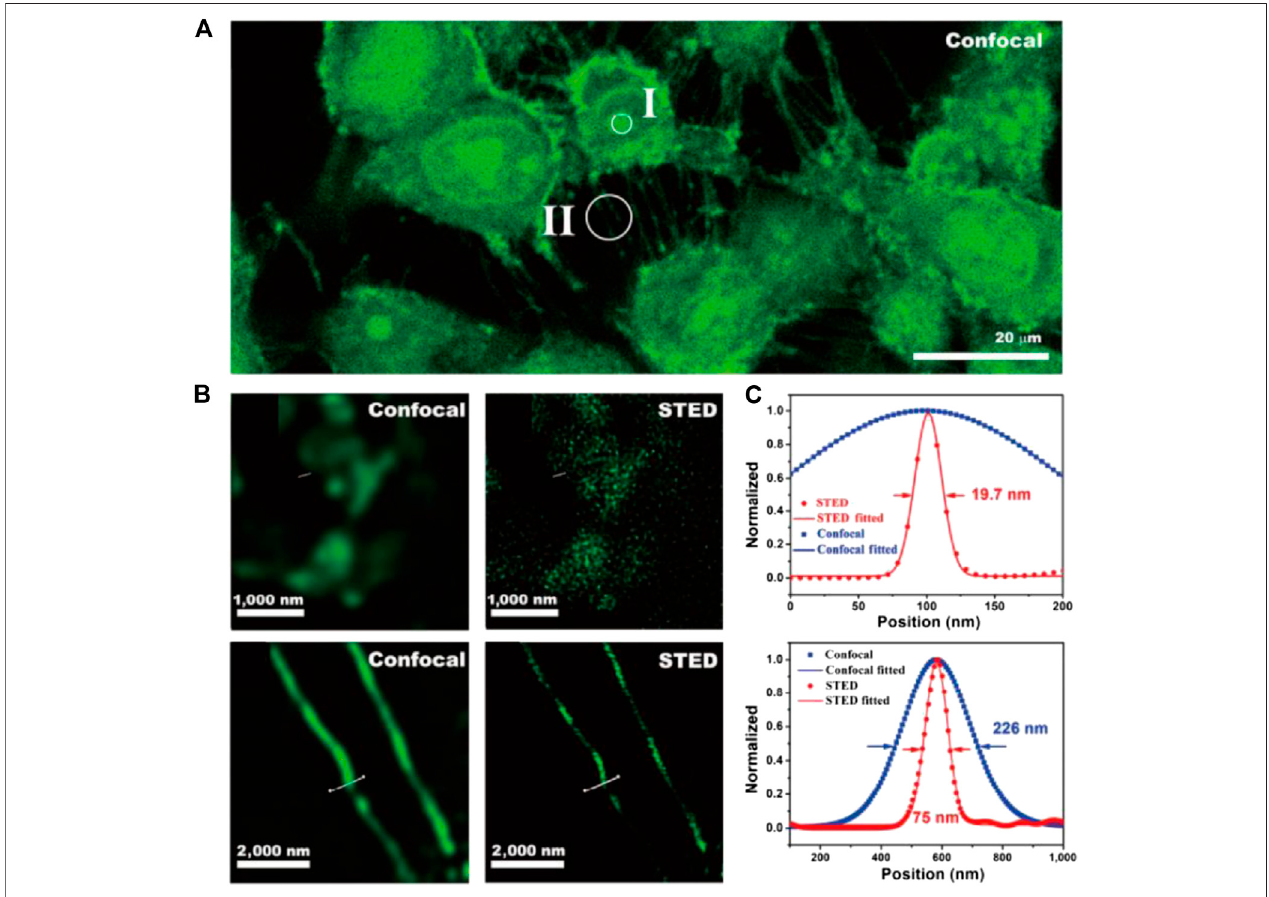
FIGURE8| STEDimagingofliving4T1cellsstainedwithCDots(Lietal.,2019). (A) Confocalimageof4T1cells. (B) ThecomparisonofSTEDandconfocalimages of cells in the nucleus (II) and tunneling nanotubes (II). (C) Plot fi le for confocal and STED results in both regions of interest.